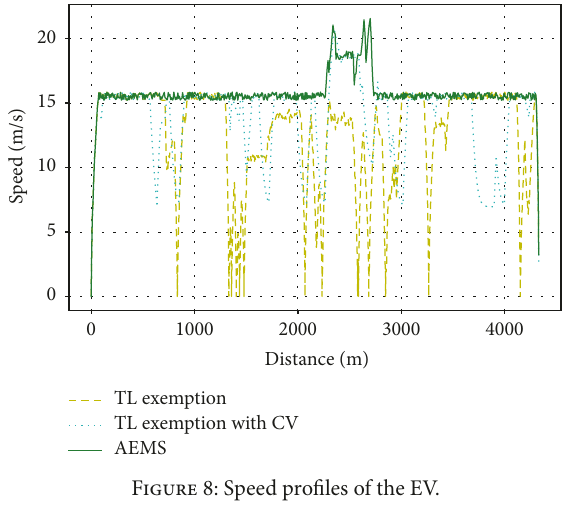
Figure 8: Speed profiles of the EV.